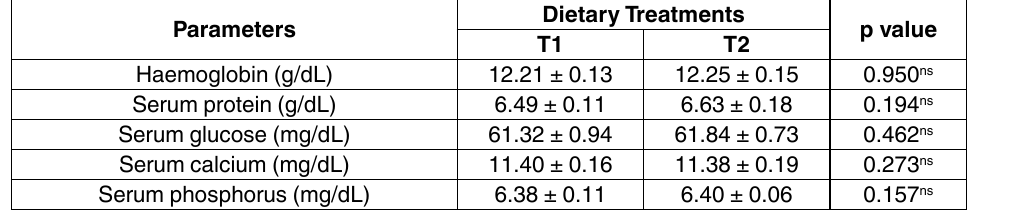
table 5. Haematobiochemical parameters 1 of the calves maintained on the two experimental rations